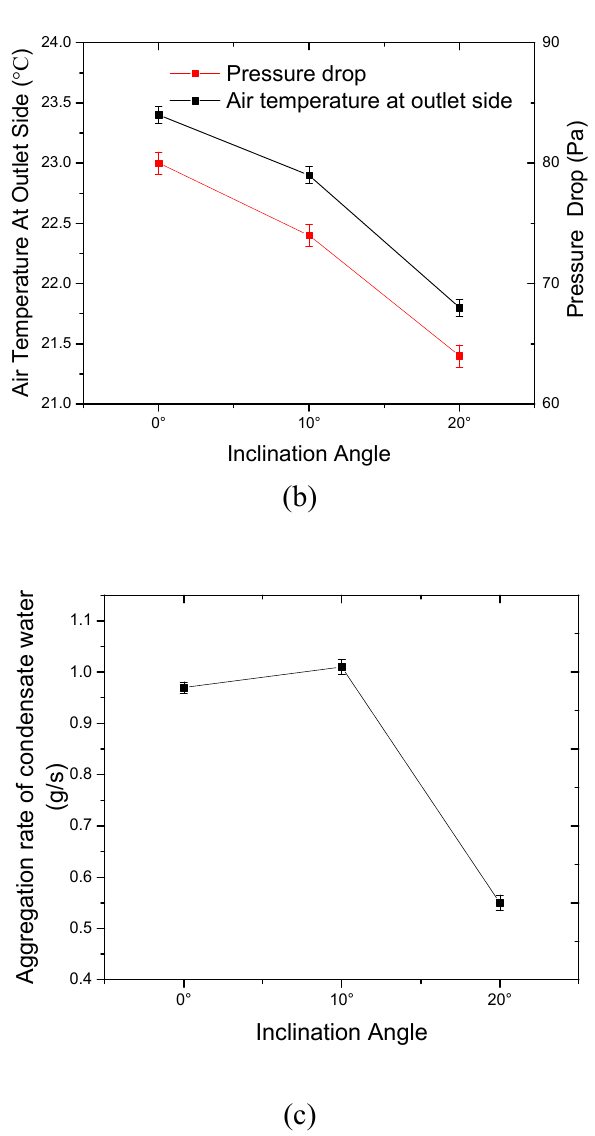
Figure 10. Variation in heat transfer characteristics under different inclined installation angles to the vertical direction: ( a ) the air-side heat transfer and overall heat transfer coefficient; ( b ) the air outlet temperature; (c) the condensate water accumulation rate.